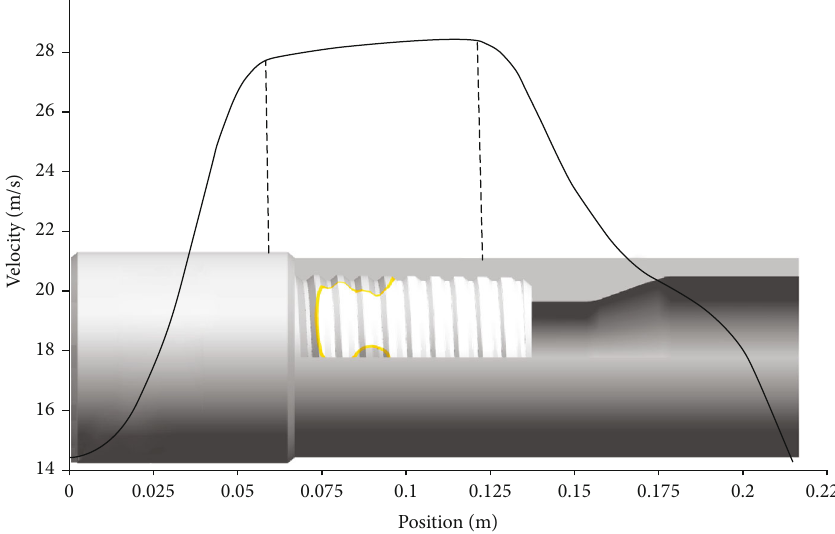
Figure 12: Velocity curve of drilling fl uid along the central axis of the coupled